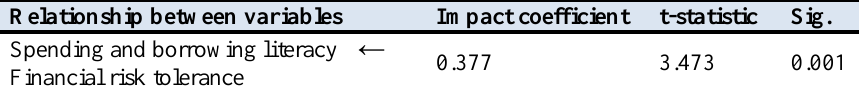
Table 7 . Estimation of the coefficients of the fourth